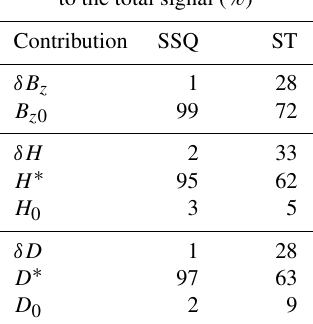
Table 3. Percentage of each contribution to the total signal (%) dur- ing both SSQ and ST